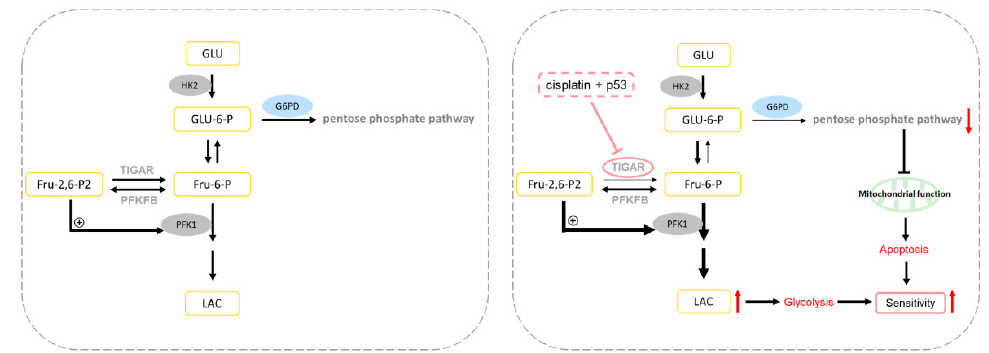
Figure 6. After combined treatment of p53 and cisplatin, modulation of TIGAR increased the flux of glucose to glycolysis, while the flux to the pentose phosphate pathway decreased, mitochondrial function was inhibited, and apoptosis was increased in lung cancer A549 cells, which increased sensitivity of lung cancer cells.